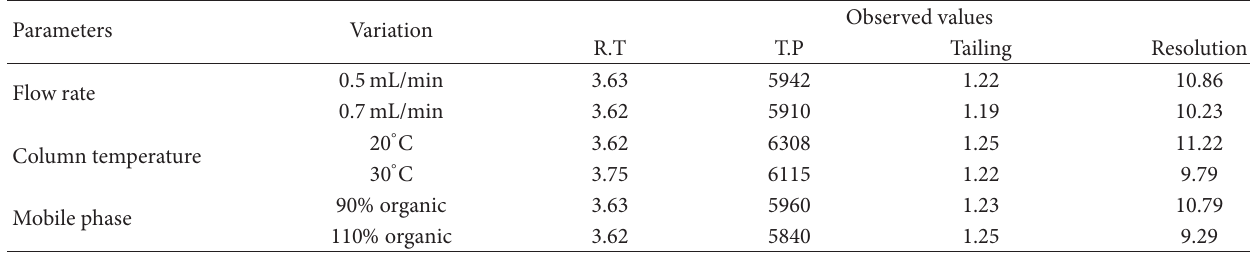
T 9: Effect of various parameters in assessment of method.